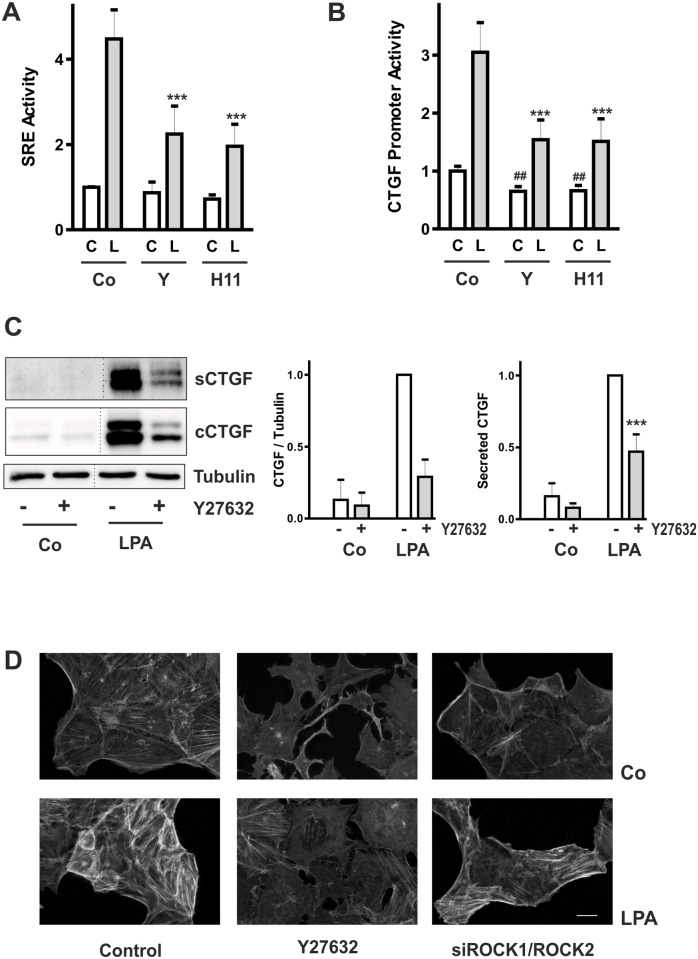
CTGF expression is dependent on Rho kinase activity.(A) HKC-8 cells were transfected with luciferase-coupled SRE constructs. Expression of transfected beta galactosidase was used as reference. Cells were preincubated for 30 min with Y27632 (Y, 10 μM) or H1152 (0.75 μM) and were then stimulated with LPA (L, 10 μM, grey bars) for 4 h. Data are means ± SD of 3 experiments with duplicate samples. In each experiment, means of control values were set to 1. *** p < 0.001 compared to LPA-stimulated control cells; ANOVA with Tukey’s multiple comparison test. (B) HKC-8 cells were treated as in A, but transfected with a 4.5 kb CTGF promoter construct. ## p < 0.01 compared to non-stimulated control cells, *** p < 0.001, compared to LPA-stimulated cells, ANOVA with Tukey’s multiple comparison test. (C) HKC-8 cells were preincubated with Y27632 (10 μM) for 30 min and then incubated with LPA (10 μM) for 2 h. CTGF was detected by Western blotting in the cell culture supernatants (secreted CTGF) and homogenates (cellular CTGF). Samples were detected on one blot which had to be rearranged (dotted line). The graphs summarize quantification of multiple experiments with LPA-stimulated cells set to 1 in each experiment: cellular CTGF: n = 2 ± half range; secreted CTGF control: n = 3, secreted CTGF LPA-stimulated: n = 6; *** p<0.001 compared to LPA-stimulated cells, ANOVA with Tukey’s multiple comparison test. (D) HKC-8 cells were transfected with siGFP or siROCK1/ROCK2 at day 1, incubated with Y27632 (10 μM) at day 2 and stimulated with LPA (10 μM) for 1 h at day 3. F-actin was visualized with PromoFluor phalloidin. Scale bar: 20 μm.